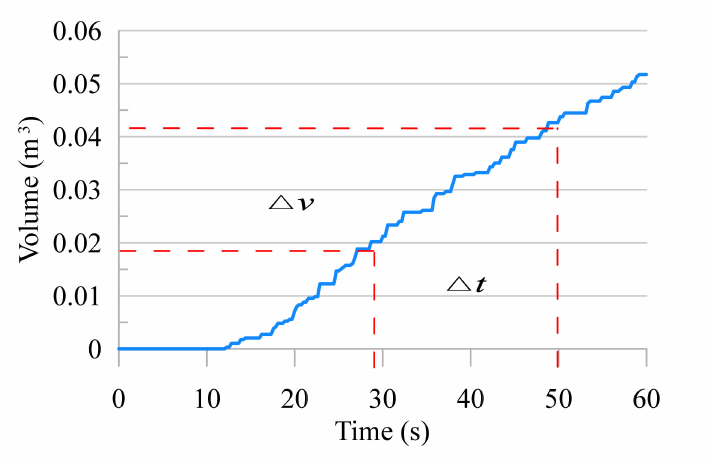
Figure 11. Range data for